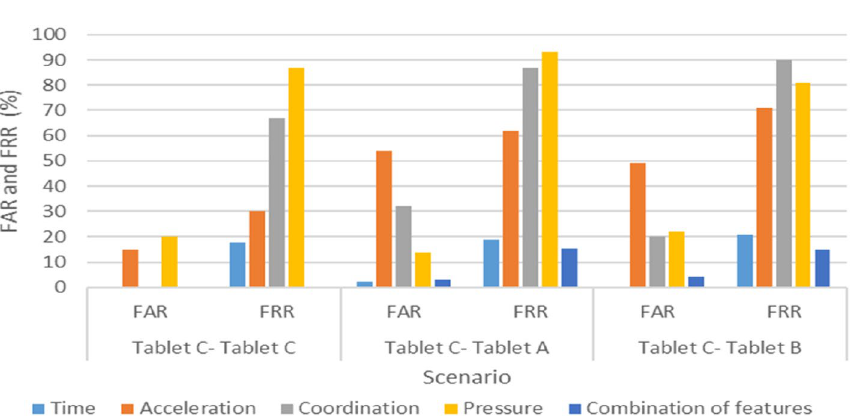
Figure 6. FAR and FRR of Scenario 3 (Tablet C–Tablet C, Tablet C–Tablet A, and Tablet C–Tablet